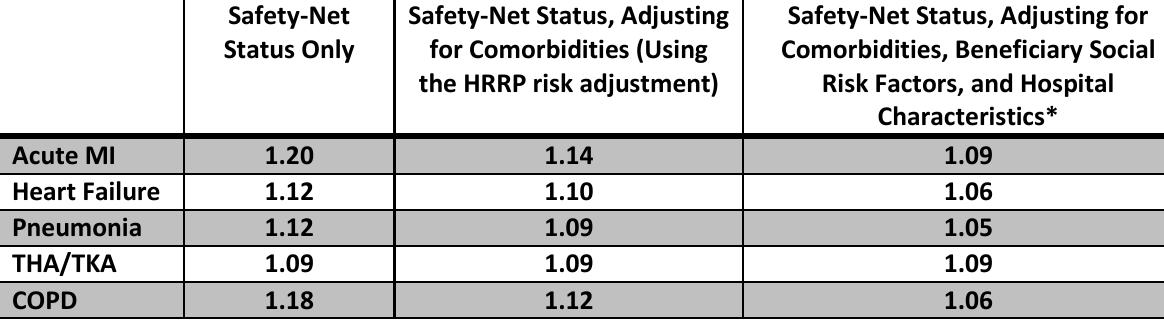
Table 5.3. Odds Ratio for Readmission for Patients Discharged from Safety-Net Hospitals Safety-Net Safety-Net Status, Adjusting Status Only for Comorbidities (Using the HRRP risk adjustment)